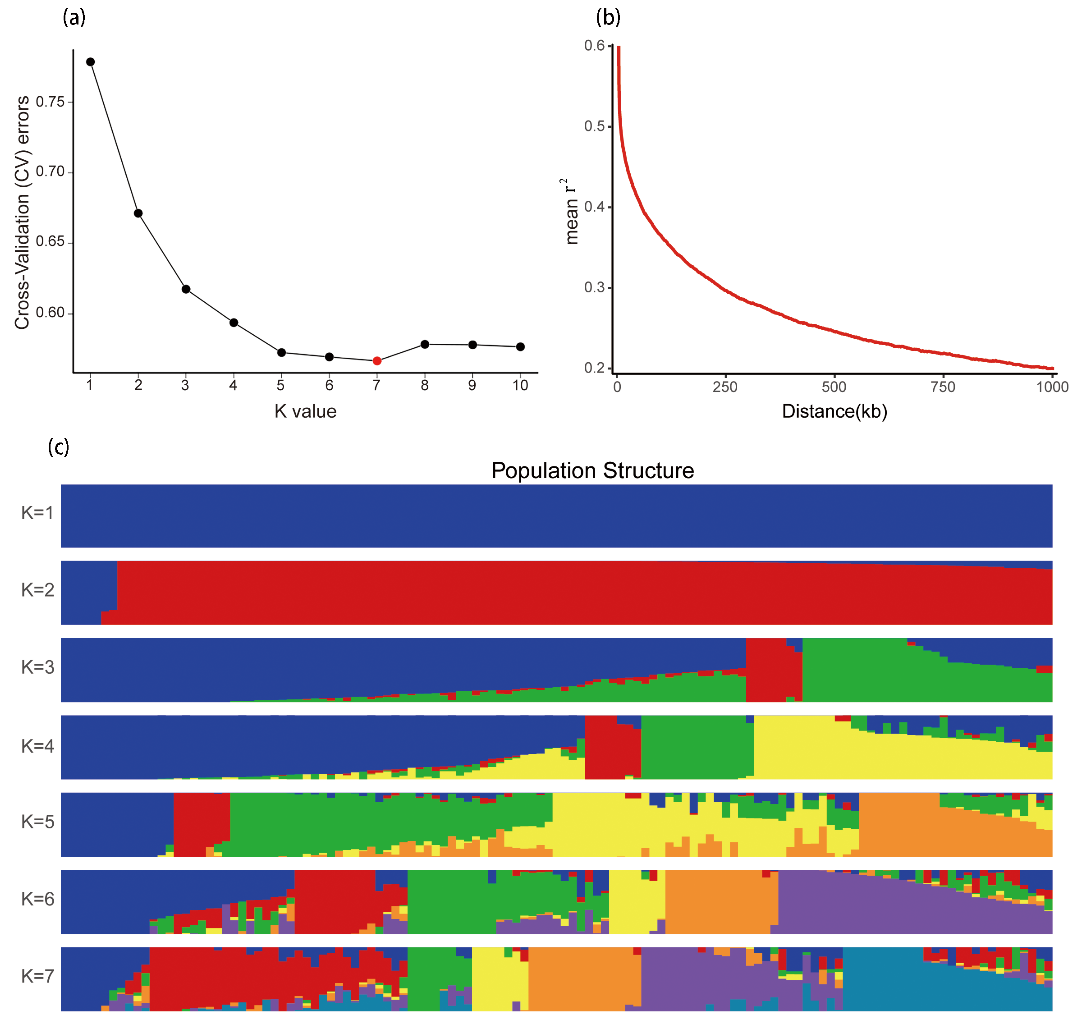
Figure 3. Cross-validation, population linkage disequilibrium attenuation, and ADMIXTURE analysis of genetic relationships. ( a ) Cross-validation (CV) scores at different K values. The lowest value (K = 7) was selected as optimal for ADMIXTURE analysis. ( b ) Average LD attenuation for the whole genome. ( c ) Visualization of genetic relationships of each rice variety based on ADMIXTURE analysis.